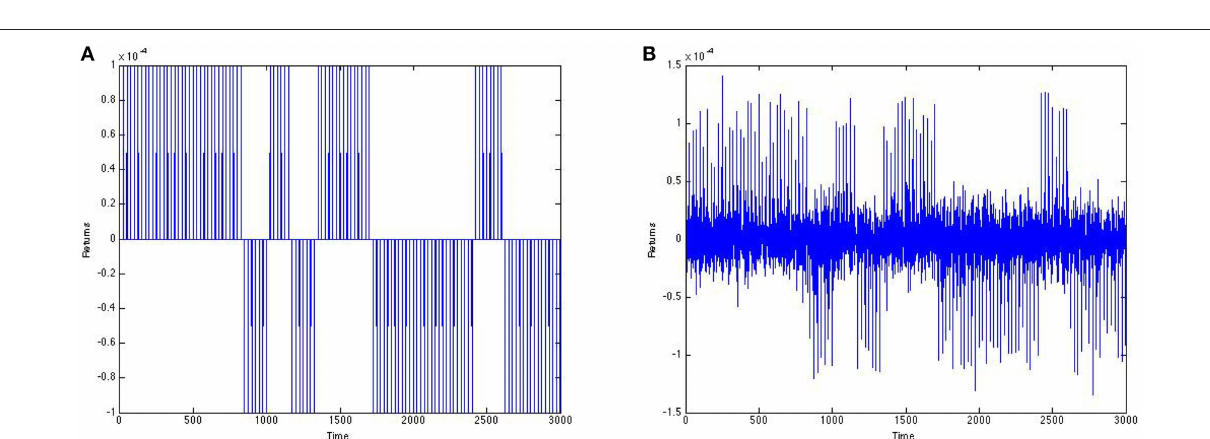
Expected duration spent in regime #1: 51.40 min Expected duration spent in regime #2: 14.07 min Figure 19 shows the state probabilities over